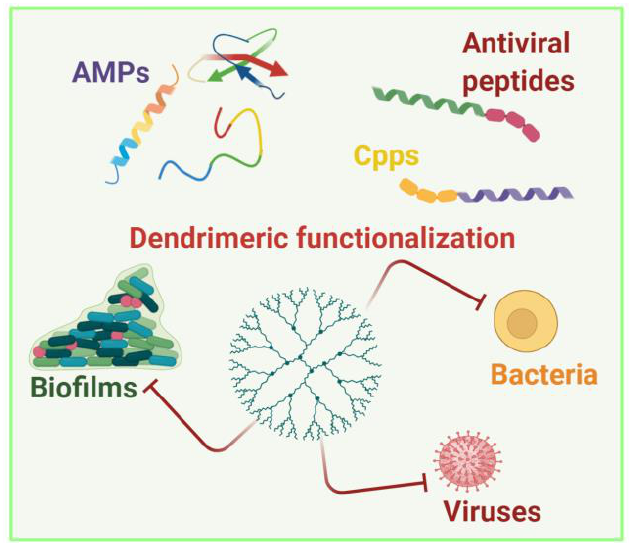
Figure 2. Dendrimers can be functionalized with antimicrobial peptides (AMPs), cell penetrating peptides (CPPs), and antiviral peptides for applications in fighting bacteria, viruses, and biofilms. Created with BioRender.com .